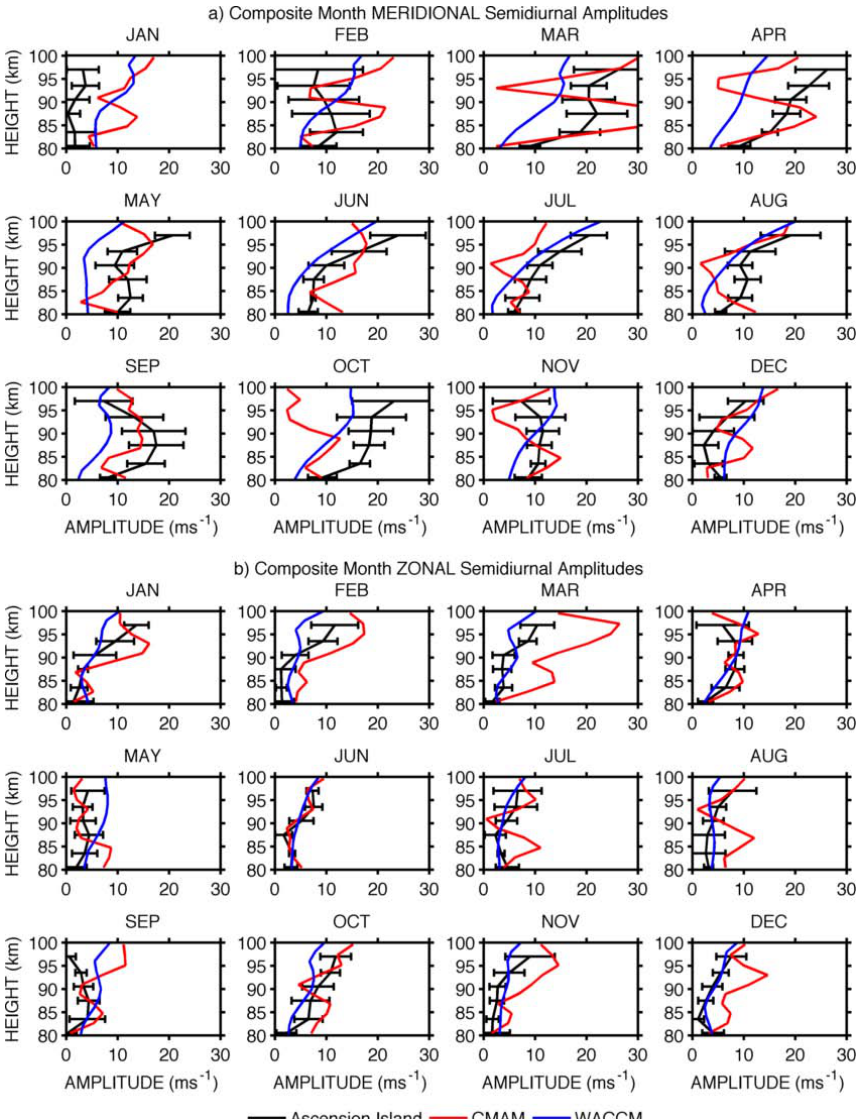
Fig. 10. Amplitudes of the (a) meridional and (b) zonal semidiurnal tide as a function of month and height. The error bars on the radar observations (black lines) indicate the standard deviation of the individual monthly means over the interval 2002–2011. Also plotted are the predictions of eCMAM (red lines) and WACCM (blue